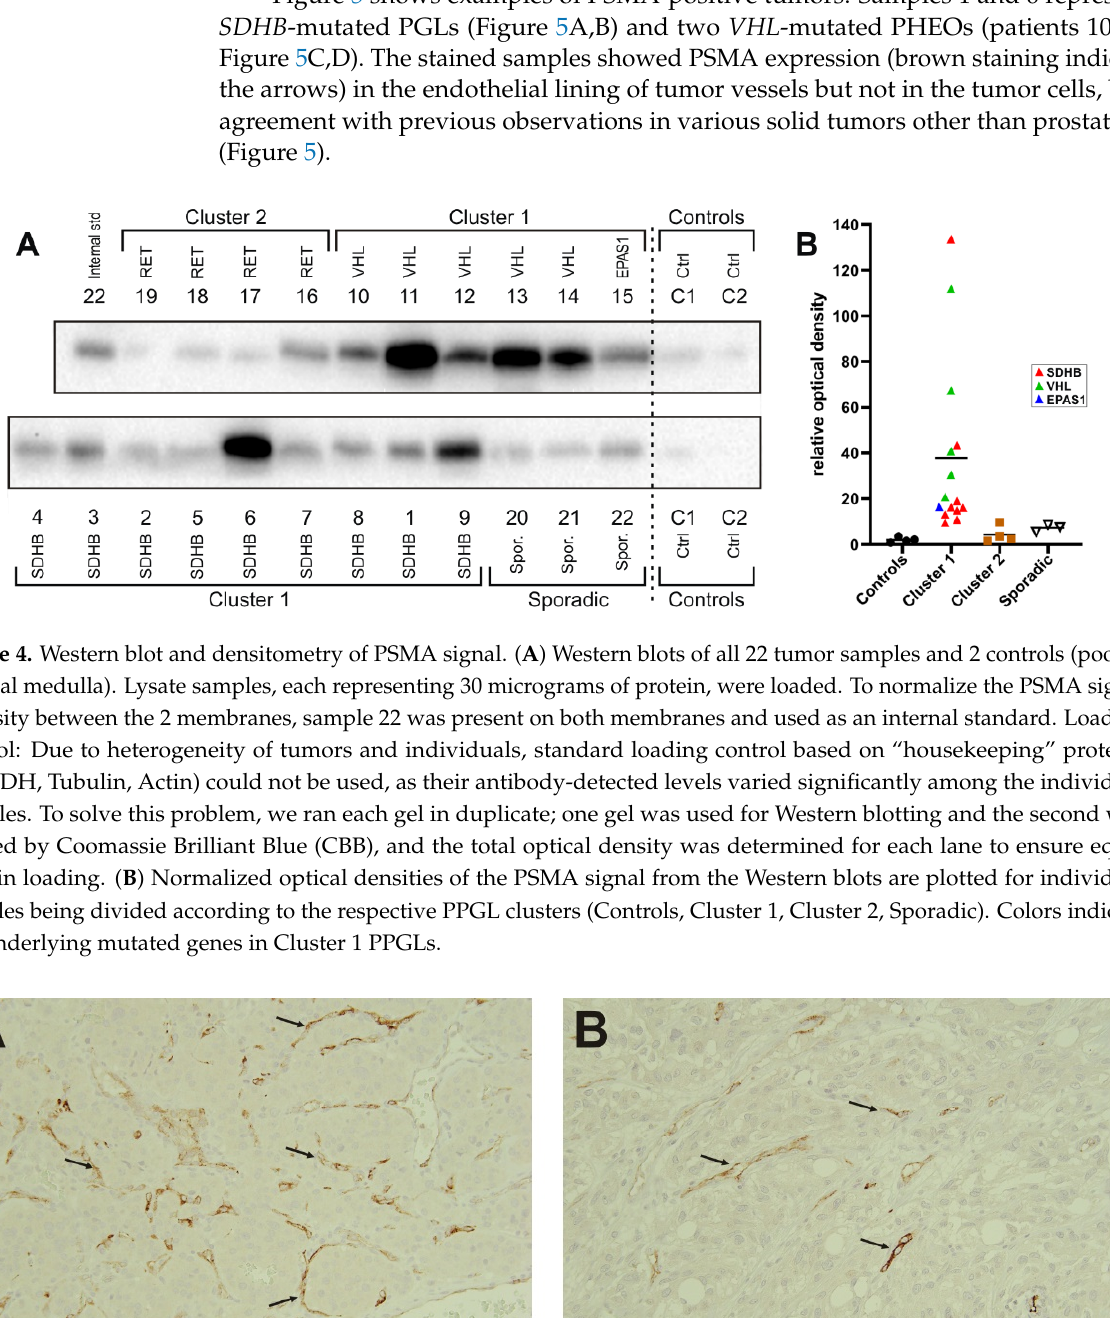
Figure 5. Immunohistochemistry. PSMA positivity and localization in Cluster 1 PPGLs. ( A ) SDHB-mutated bladder PGL (patient 1). ( B ) SDHB -mutated mediastinal PGL (patient 6). ( C ) VHL-mutated pheochromocytoma (patient 10). ( D ) VHL- mutated pheochromocytoma (patient 12). Brown PSMA staining in endothelial lining of tumor vessels is indicated by arrows. 3. Discussion 3.1. PSMA—An Effective Theranostic Target PSMA is a type II transmembrane glycoprotein with folate hydrogenase and carbox- ypeptidase activities coded by FOLH1 gene. PSMA has a large glycosylated extracellular domain responsible for its enzymatic activity, a transmembrane segment, and a short in- tracellular domain. The short cytosolic tail contains an internalization motif and interacts with various proteins enabling PSMA endocytosis [20]. The molecule is overexpressed in prostate cancer where it correlates with tumor aggressivity and vascularization and it is used as a target for radioconjugates for prostate cancer imaging (FDA approval in 2020) and recently also for therapy of advanced prostate cancer [12,13]. In addition to prostate cancer, PSMA expression has been demonstrated in several solid tumors [16–19]. Using a hypothesis-free deep proteomic profiling of PGL membrane proteome, we identified a subset of “tumor enriched” IMPs including PSMA. Antibody-based verifica- tion was performed in a panel of 22 PPGLs representing two of the three main PPGL clus- ters [2,4]: Clusters 1 and 2, which can be attributed to pathogenesis in nearly 90–95% of all